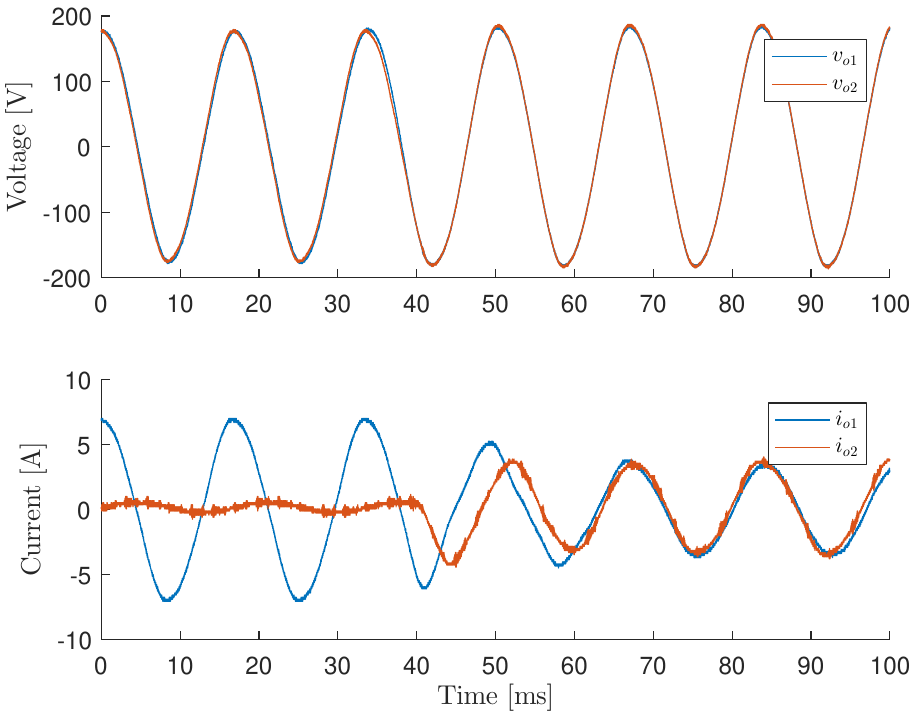
Figure 15. Connection of the second inverter in the microgrid. As seen in Figure 15, current i o 2 quickly synchronizes with i o 1 . In addition, a soft transient is achieved due to the pre-synchronization procedure. The difference between i o